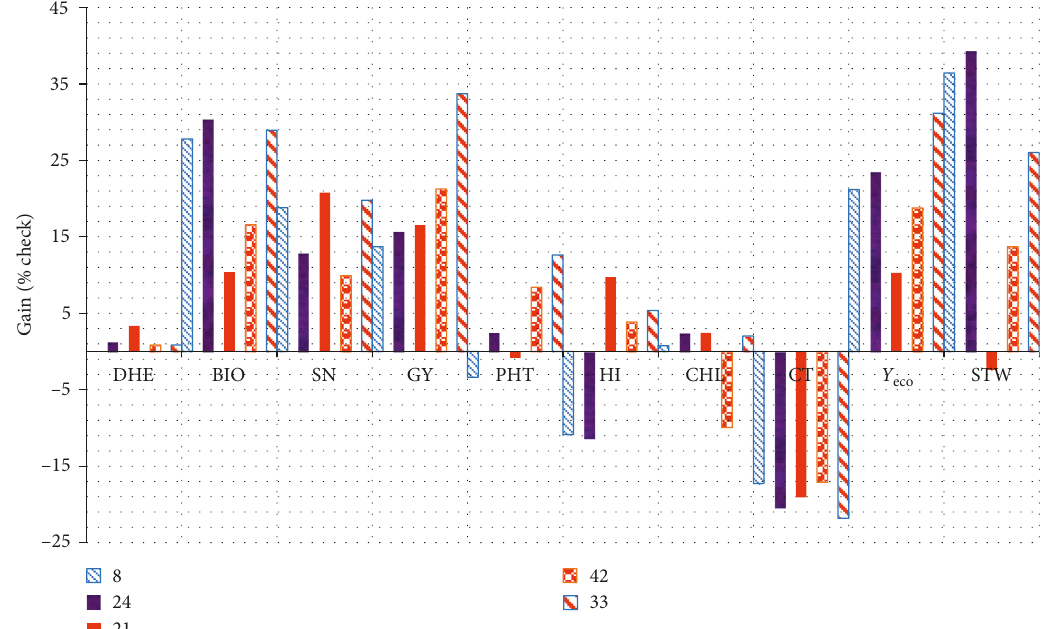
Figure 2: Gain (% of check) for the measured traits brought by selection of the 5 best yielding entries from cluster